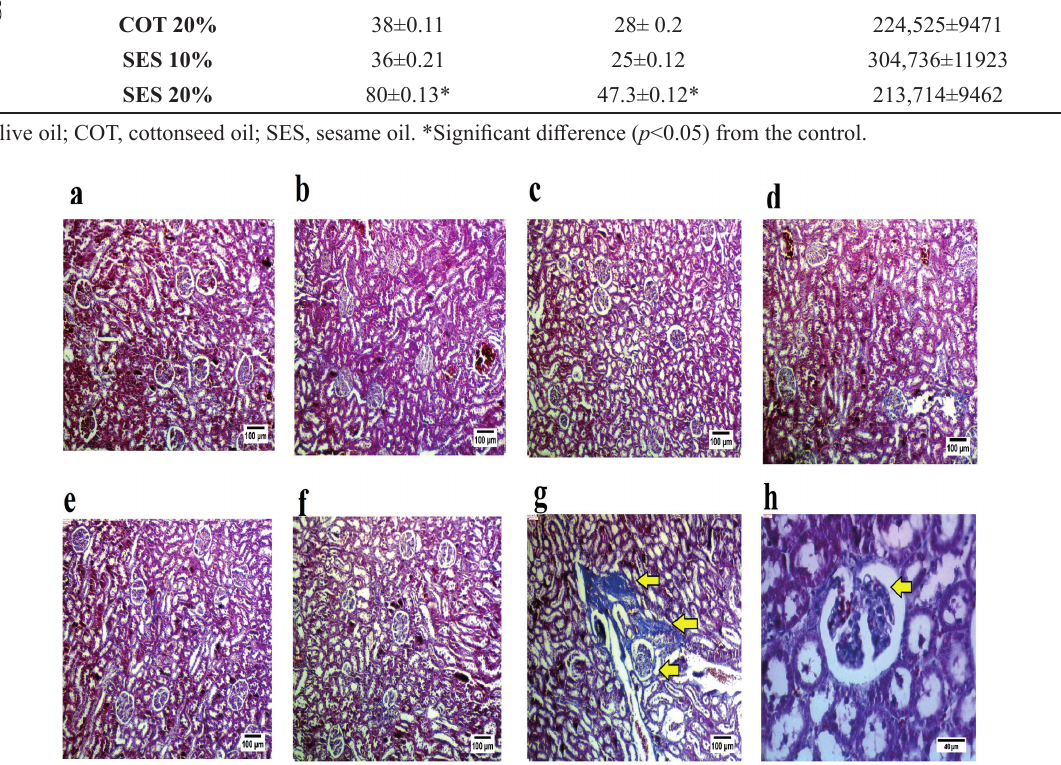
Figure 5 - Evaluation of renal collagen deposition using Masson’s Trichrome staining. Control ( a ), Olive 10% ( b ), Olive 20% ( c ), Cottonseed 10% ( d ), Cottonseed 20% ( e ), Sesame oil 10% ( f ) and Sesame oil 20% ( g , h ). The arrows clearly show collagen deposition areas (blue fibers) both in glomeruli and